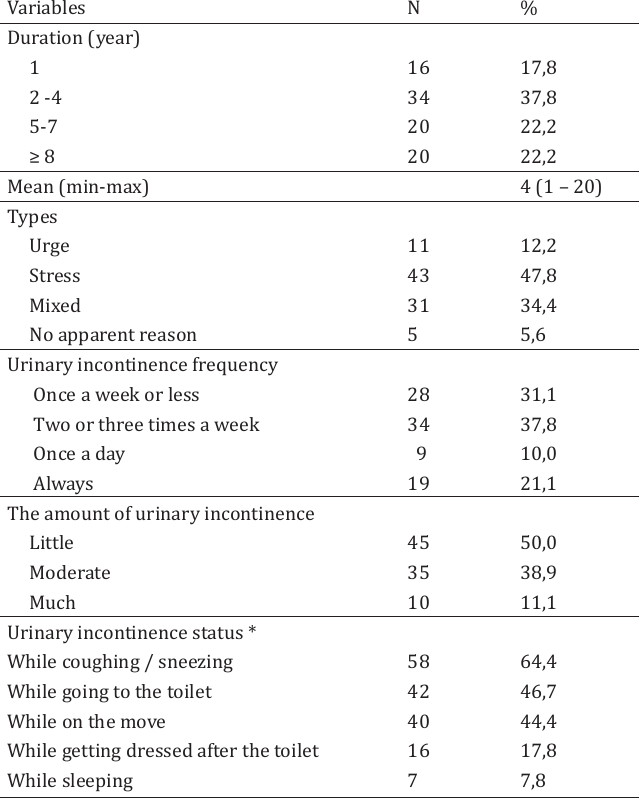
Characteristics of women related to UI